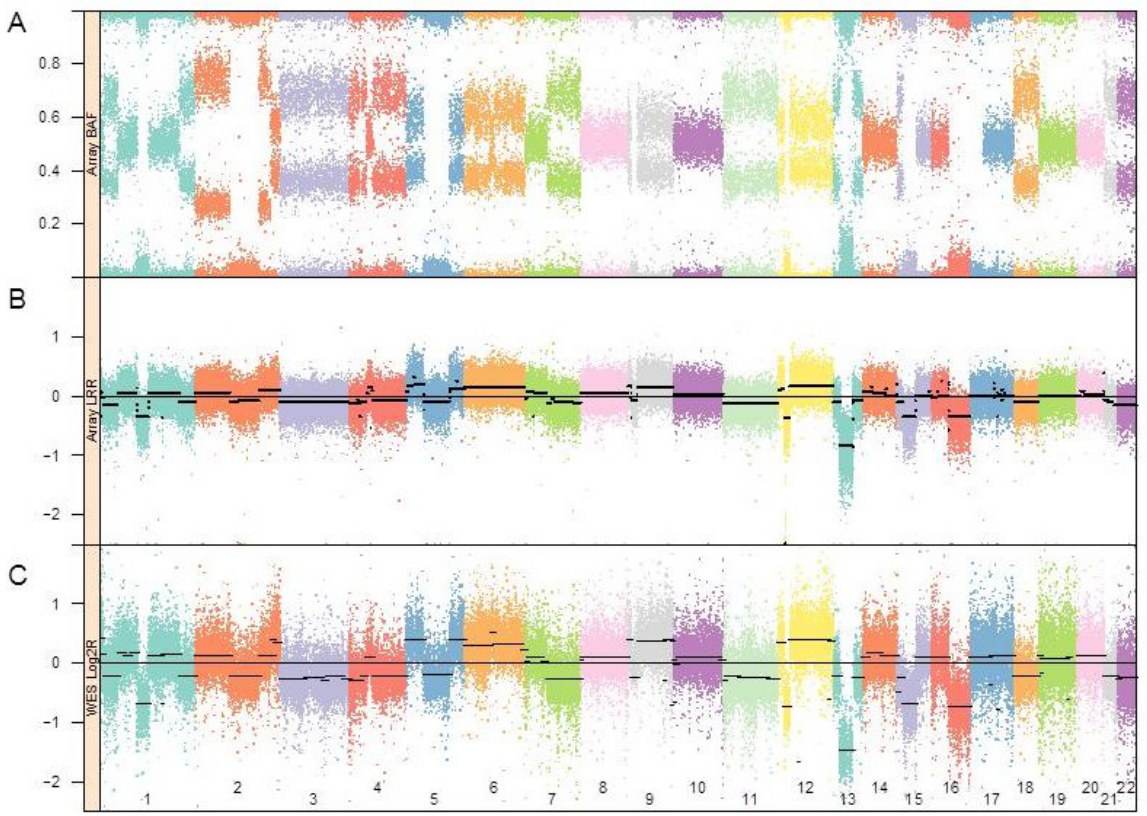
Figure 1. Allele frequencies ( A ) and log R ratios ( B ) estimated by GenomeStudio. Autosomal log R ratios were segmented by circular binary segmentation [11] as indicated in black; ( C ) Log R values from whole exome sequencing were obtained by the EXCAVATOR program [12] and aligned to panels A and B, providing a qualitatively similar profile of the copy number alterations. Black lines depict the segmentation of the log R